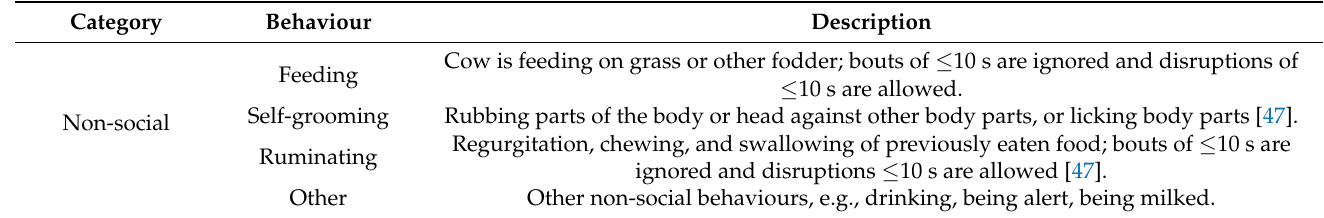
Table 2. Ethogram of the analysed duration behaviours recorded during the first part of the study (horn temperature in relation to behaviour and environment). Videos were scored for state/duration behaviours using the continuous focal sampling method. Category Behaviour Description